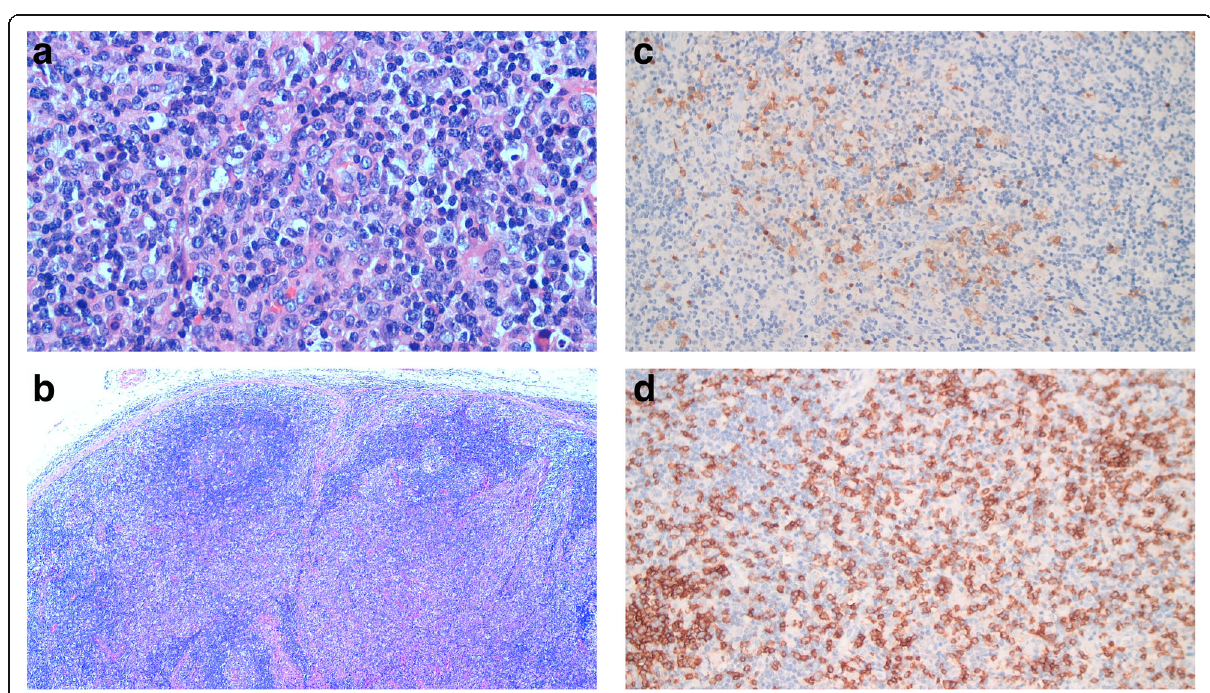
Fig. 3 Microscopic features. a . A small number of histiocytes (black arrows) have distorted and elongated nuclei with irregular shapes (HE, × 400); b . High endothelial venule proliferation in the paracortical area (HE, × 40); c . The proliferating histiocytic fraction of the paracortical area expresses S-100(Envison, × 100); d . Proliferating CD8-positive T cells in the paracortical zone (Envison, ×